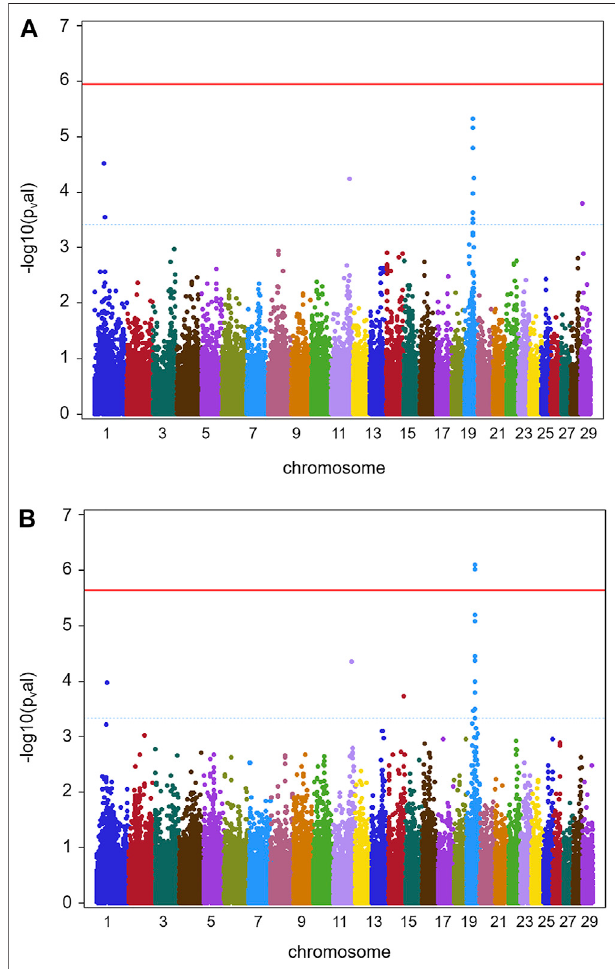
FIGURE 2 | GWAS results for full data (batch 1 and 2) (herds 1 – 13). (A) ManhattanplotobtainedfromtheresultsofGWASanalysis(Ensembl genome assembly UMD3.1) for trait TBIN. (B) Manhattan plot derived from the data of GWAS analysis for trait TCHRONA. In all plots -log10 p -values of detected SNP sorted by chromosomes are shown. Red line indicates genome-wide (5%) false discovery rate (FDR). Blue dotted line indicates chromosome-wise (5%) FDR with lineand corresponding chromosome ofthe same